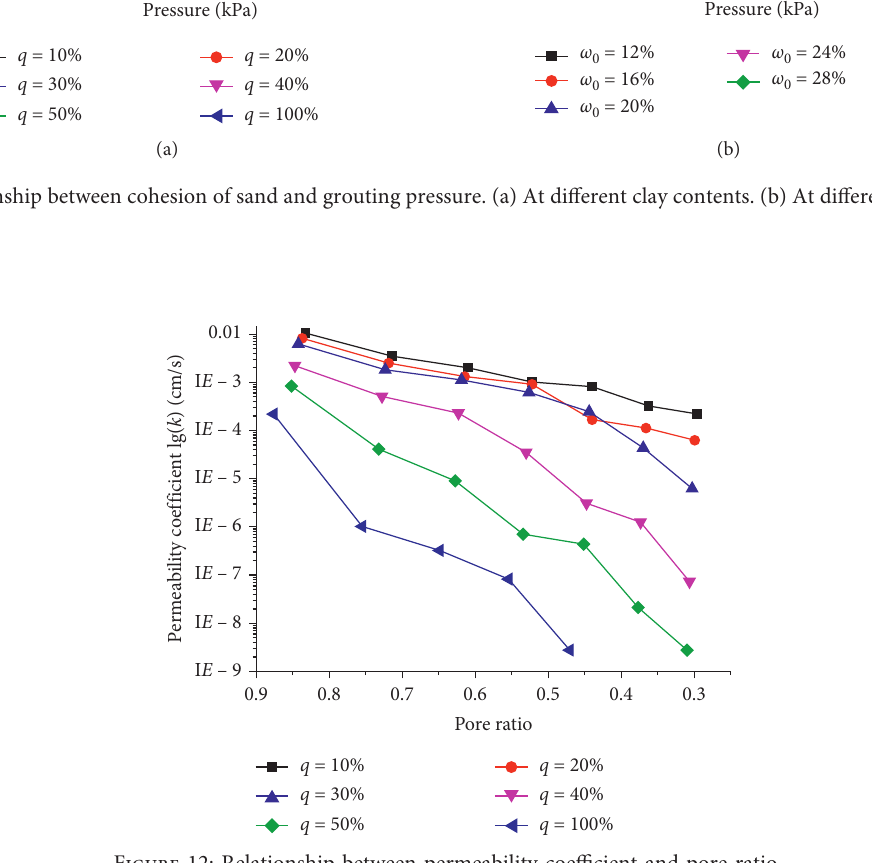
Figure 12: Relationship between permeability coefficient and pore